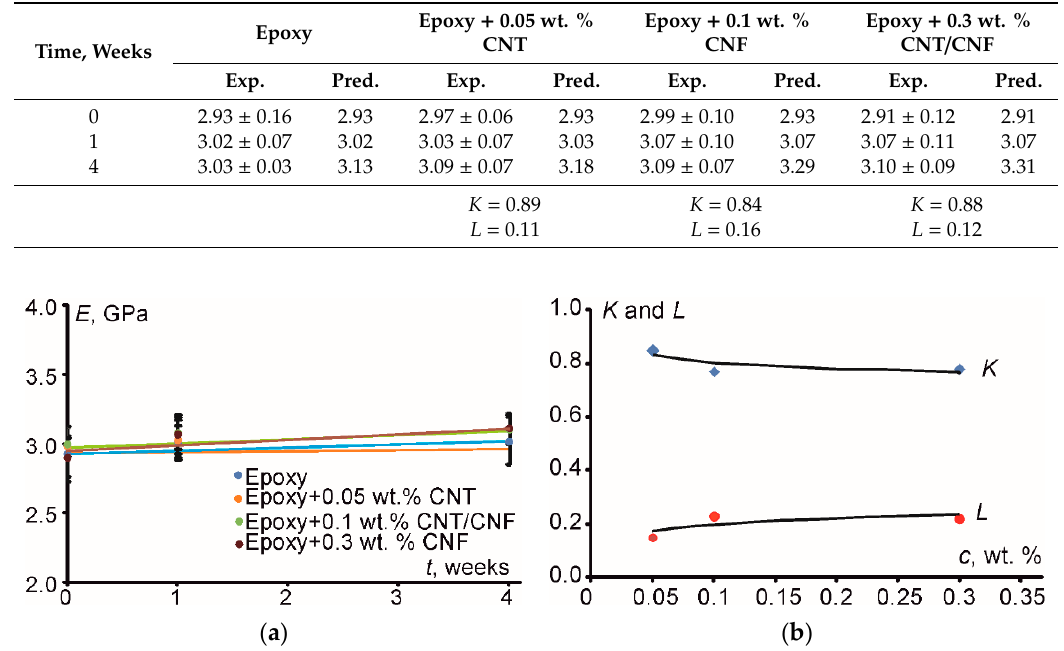
Table 2. Experimental and predicted elastic modulus for the specimens heated at 70 ◦ C.